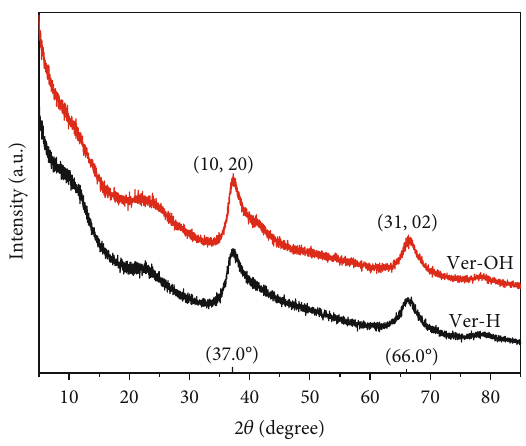
Figure 1: XRD spectra of vernadite